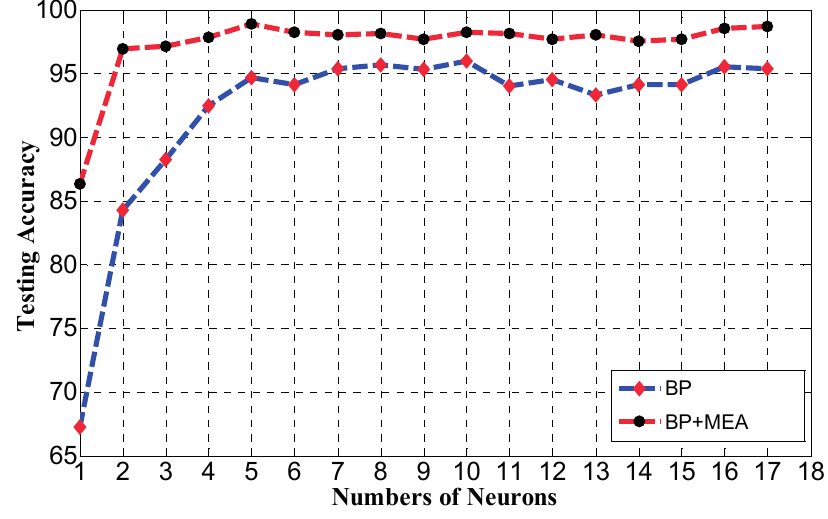
Figure 10. Testing accuracy comparison between BP and BP optimized by MEA for various numbers of hidden neurons.